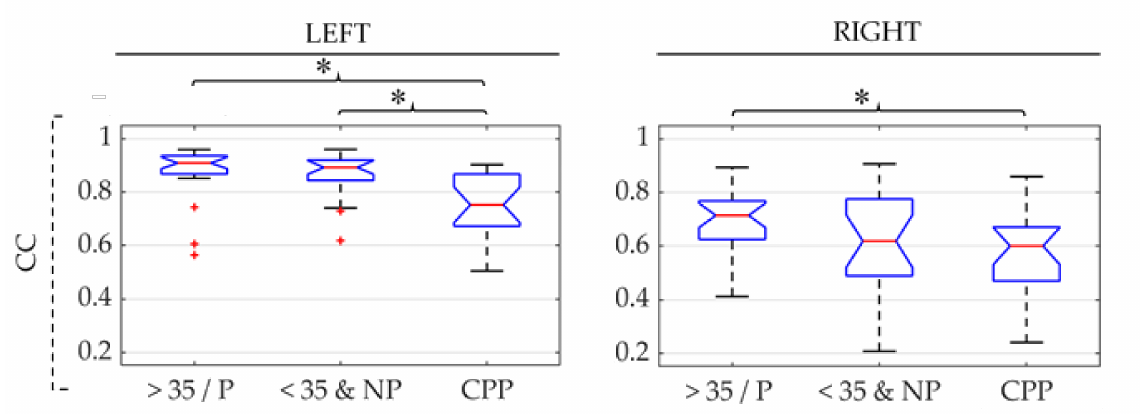
Figure 7. Box-whisker plots of cross-correlation (CC) values between the upper and lower sides of the left and right PFM (left and right subfigures, respectively) in patients (CPP), healthy women over 35 and/or parous (>35/P) and healthy women under 35 and nulliparous (<35&NP) during the five PFM contractions and relaxations between them (first and second rows, respectively). (*): significant difference between groups under the ends of the brace. Red (+): outlier within the group’s data distribution. Table 2. Summary of differences between the sEMG characteristics of patients (CPP), healthy women over 35 and/or parous (>35/P), and under 35 and nulliparous (<35&NP). Results of PFM left and right sides during contraction and relaxation. Cells show the parameters with a significant difference between groups. Arrows ↑ or ↓ are displayed to indicate higher or lower value in the first than in the second group. CPP vs. >35/P CPP vs. <35&NP >35/P vs. <35&NP Left Right Left Right Left Right RMS